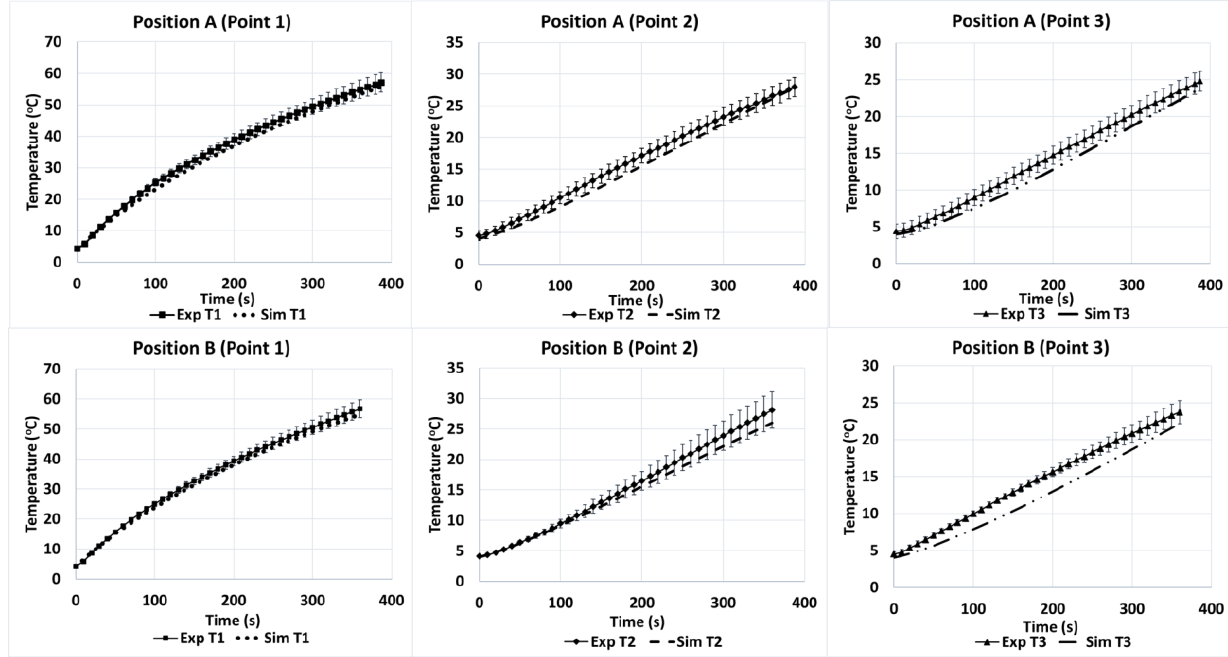
Figure 8. Temperature profiles of three points (1, 2 and 3) inside the Tylose ® sample during experi- mental heating at positions A and B (Exp) compared to simulation (Sim).